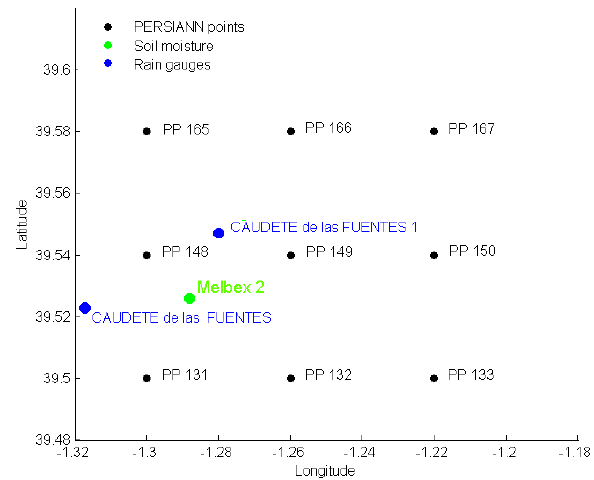
Fig. 3. Positions of Caudete de las Fuentes (CA FU) and Caudete de las Fuentes 1 rain gauges (blue dots), PERSIANN neighboring points (black dots with number of reference), and the Melbex 2 soil moisture campaign site (green